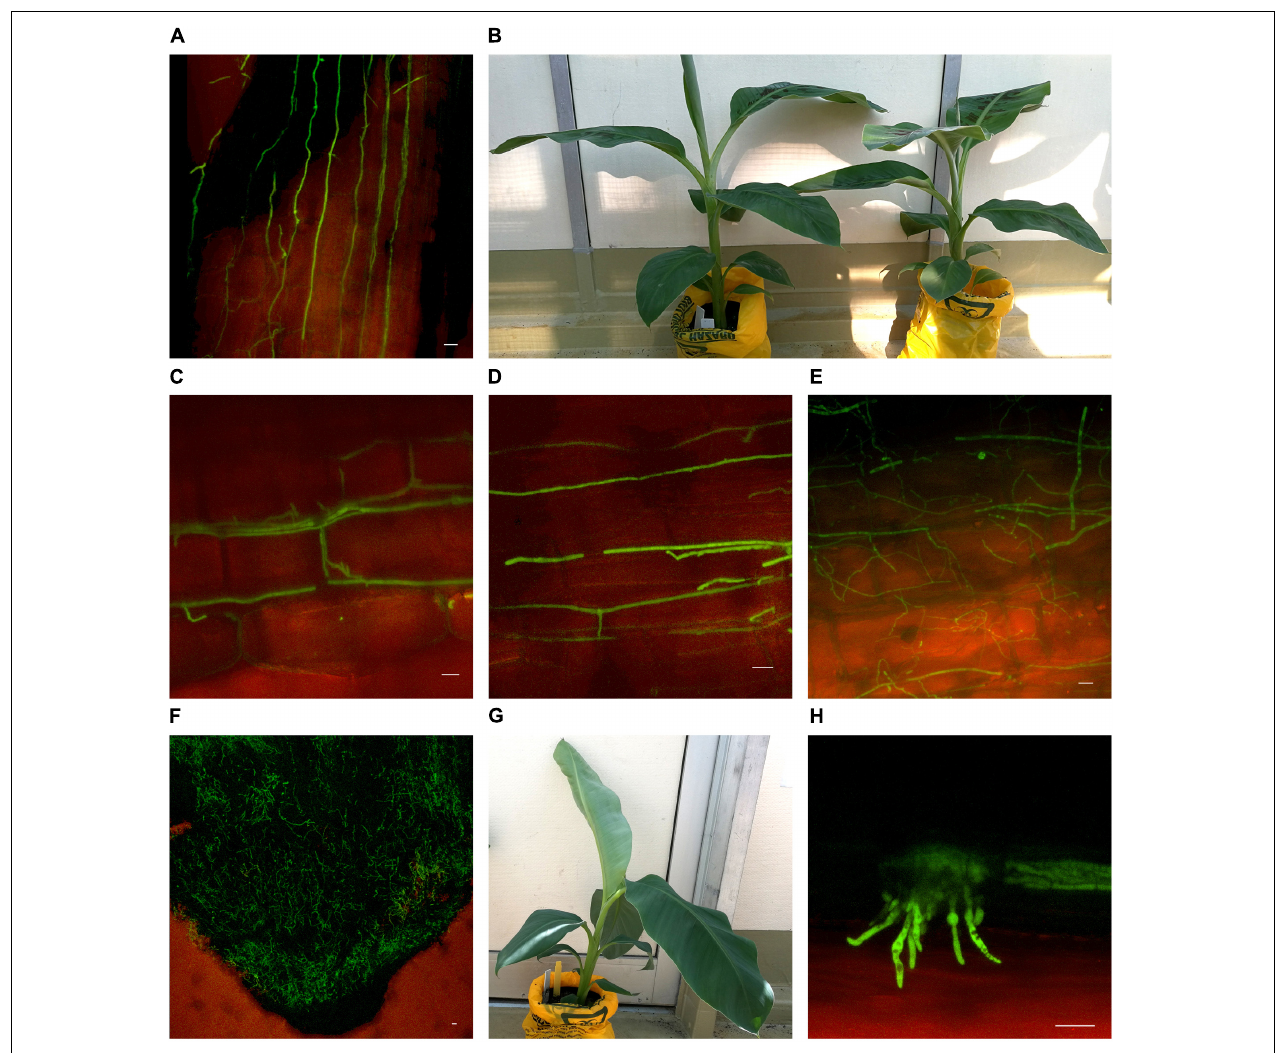
FIGURE 3 | Confocal microscopy highlighting the presence of fluorescing Fusarium oxysporum f.sp. cubense in different locations in the roots of Cavendish and Lady Finger banana plants. (A) Sample from a Cavendish root 20 dpi, showing hyphae apparently progressing through the intercellular spaces in the elongation zone above the root tip. (B) Cavendish plants at 20 dpi showing no symptoms of Fusarium wilt, plant on right inoculated with Foc GFP and plant on left inoculated with sterile millet. (C,D) A Cavendish root 50 dpi, showing hyphae present in the intercellular spaces between cortical cells. (E) A sample from a Lady Finger plant at 70 dpi, showing a decaying root with mycelial growth unconfined and throughout the cortical tissue. (F) Lady Finger roots 20 dpi, showing a mycelial network covering entire root tip. (G) Lady Finger plant at 20 dpi inoculated with Foc GFP and not showing symptoms of Fusarium wilt. (H) A Cavendish root sample 30 dpi, with macroconidia forming on the outside of root surface. Scale bars represent 20 µ